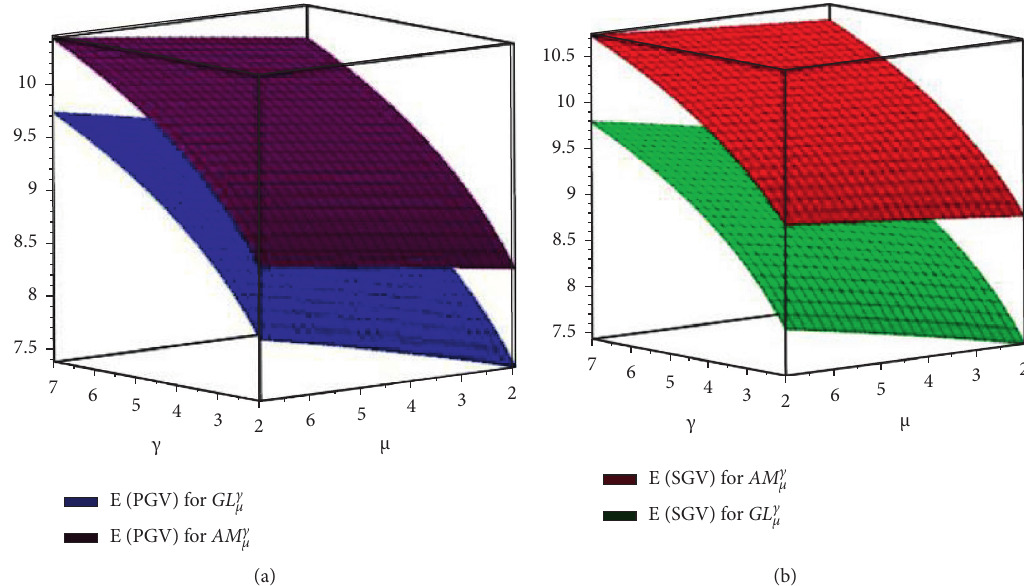
c μ and AM μ and (b) the sum connectivity